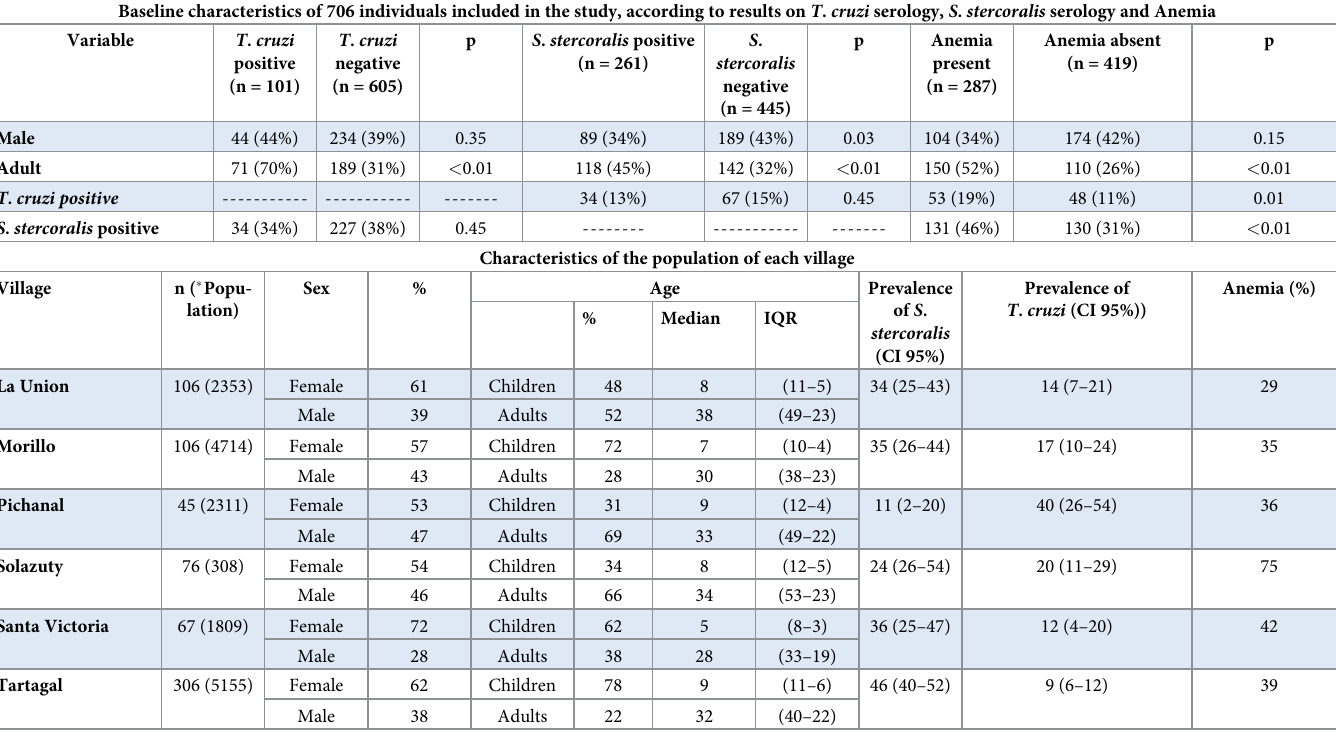
Table 1. Characteristics of the individuals included in the analysis. Baseline characteristics of 706 individuals included in the study, according to results on T . cruzi serology, S . stercoralis serology and Anemia